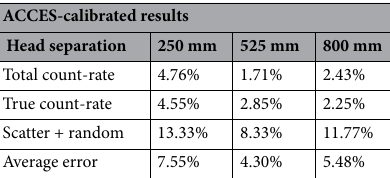
Table 4. Mean absolute percent differences in the count rate of the ACCES-calibrated digitizer model.